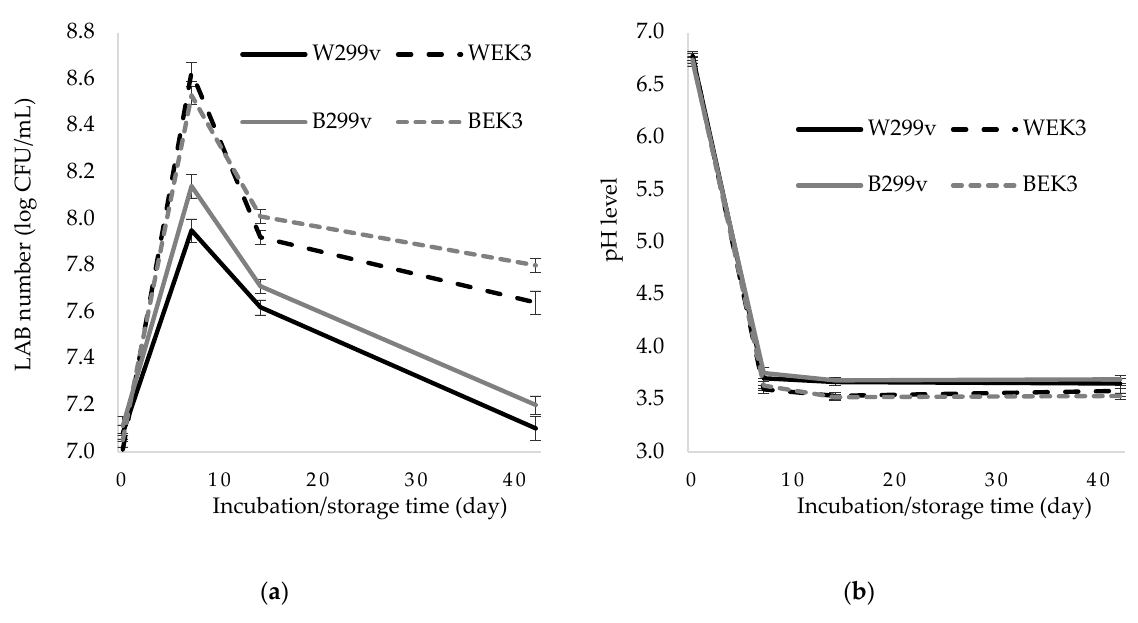
Figure 1. Changes in the number of LAB ( a ) and the pH value ( b ) in the fermented mushrooms. W—white button mushroom; B—brown button mushroom; EK3, 299v—starter cultures.